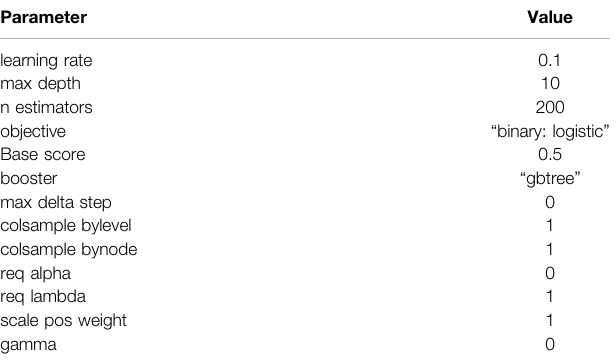
TABLE 3 | Summary of best parameters for XGBoost. Parameter